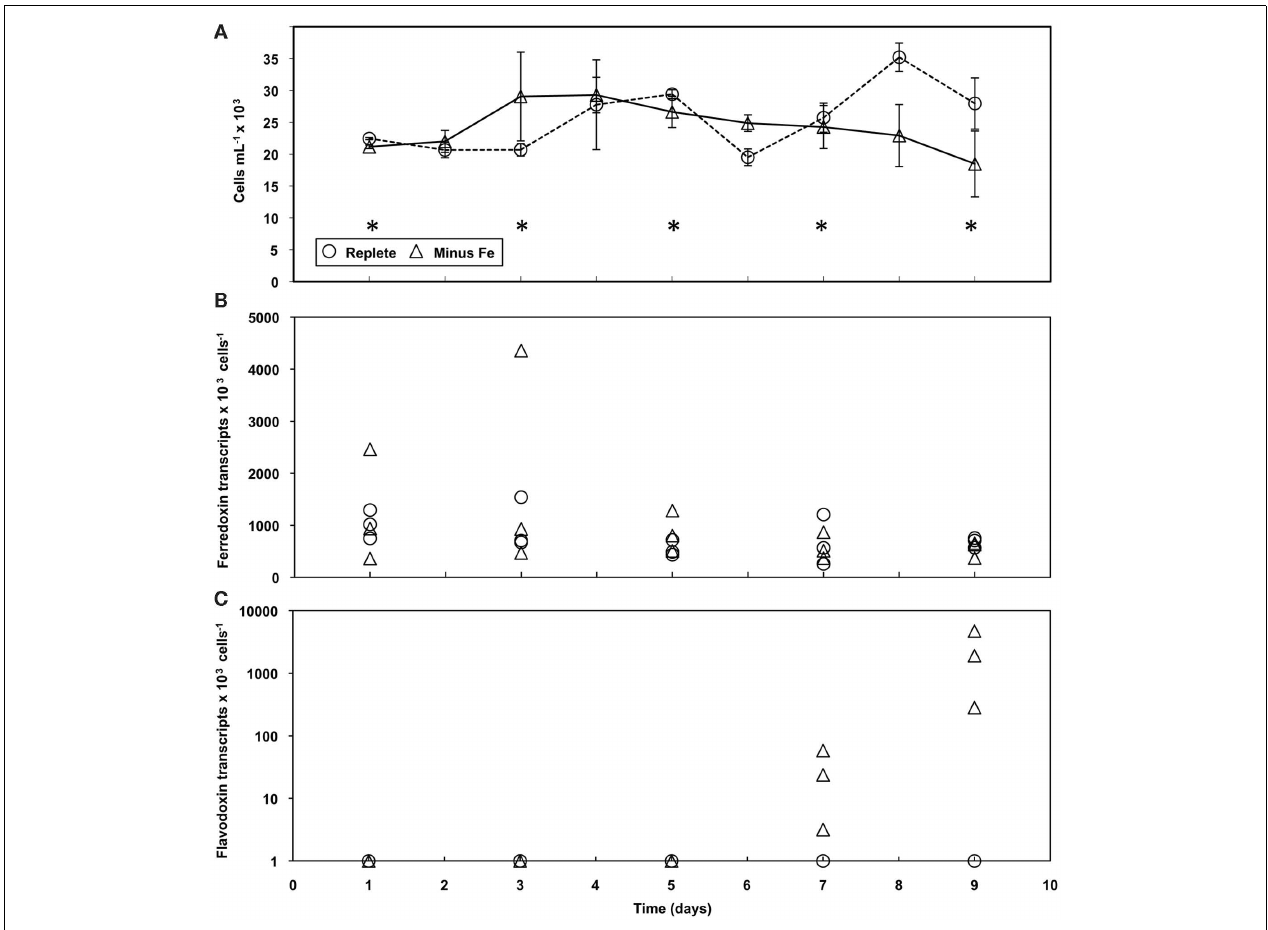
Asterisks indicate days analyzed for gene expression.Transcript copies of (B) ferredoxin and (C) flavodoxin normalized to cell number (note the change in scale). Results from each culture replicate are